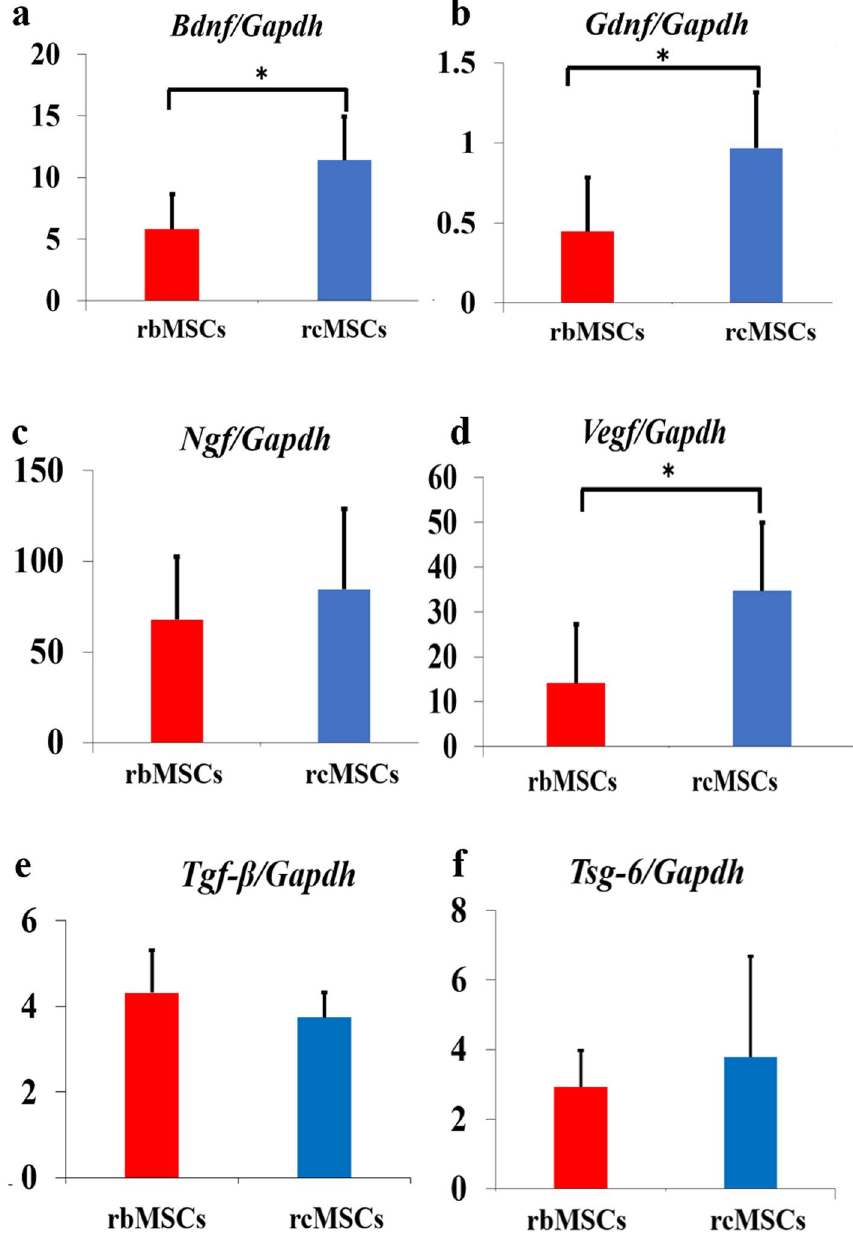
Figure 1. Real-time PCR analysis of neurotrophic and anti-inflammatory factor-associated genes. mRNA levels of Bdnf ( a ), Gdnf ( b ), Ngf ( c ), Vegf ( d ), Tgfb ( e ) , and Tsg6 ( f ) relative to Gapdh expression. Data are presented